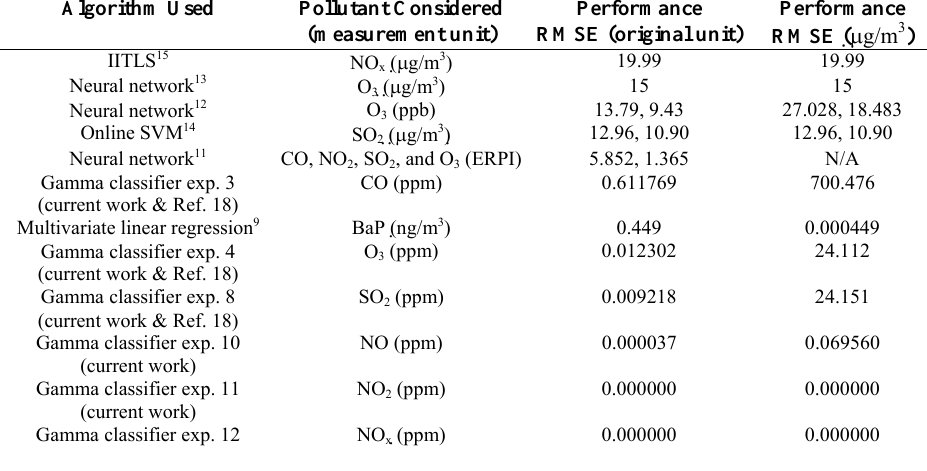
Table 6. Comparison of related results (diverse databases) in RMSE; exp. means “experiment”, N/A means “not